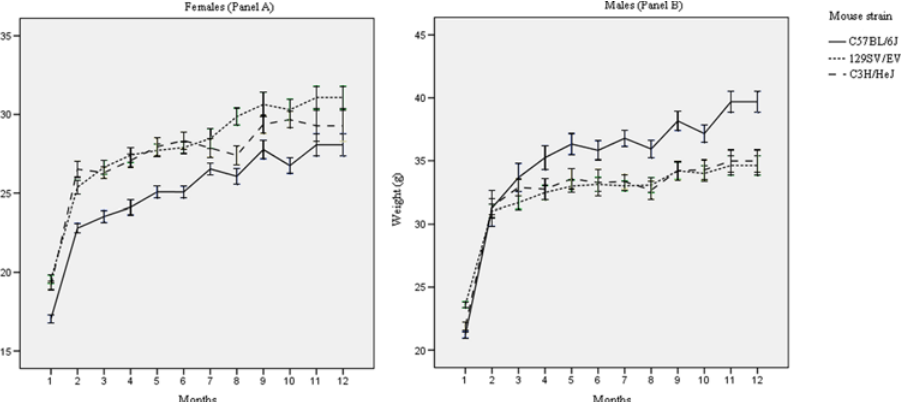
Figure 1. Female (Panel A) and male (Panel B) mice weight curves. Weight curves (mean 6 SE) of the three mouse strains (C57BL/6J, 129SV/EV and C3H/HeJ) in the one year period of the